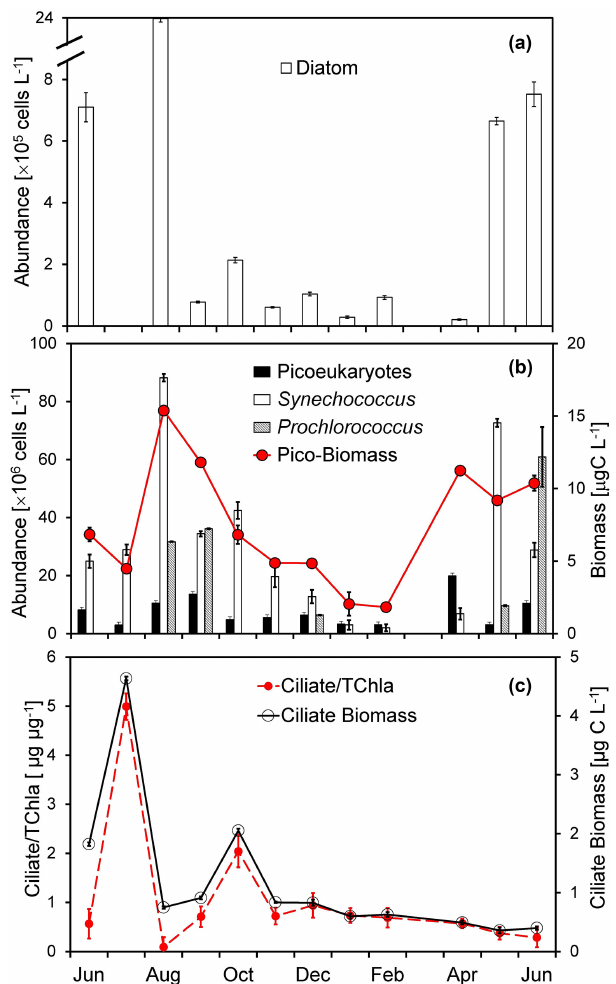
Figure 4. Temporal changes of (a) diatom abundance, (b) Syne- chococcus and pico-eukaryote abundances, total picophytoplankton biomass, and (c) ciliate biomass and the ciliate-to-chlorophyll ratio of the surface water at the Wanshan station from June 2018 to June 2019. Error bars are standard